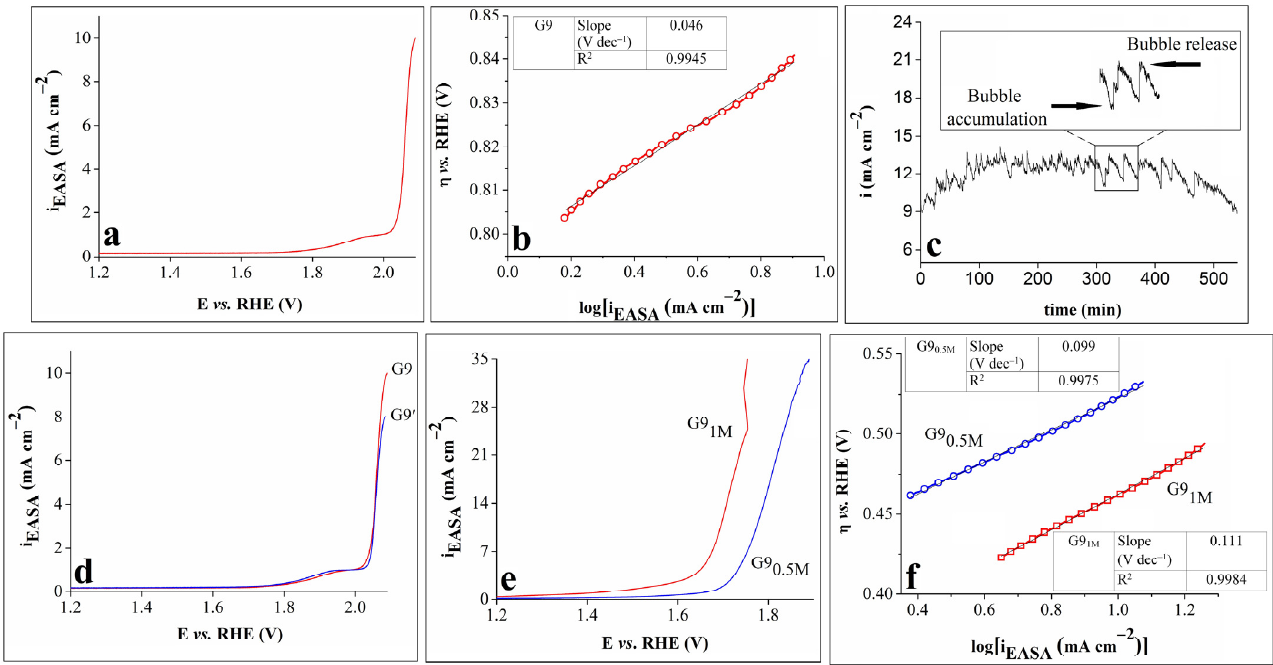
Figure 4. ( a ) LSV obtained on the G9 electrode in 0.1 mol L –1 KOH solution. ( b ) The Tafel curve for the G9 electrode in 0.1 mol L –1 KOH solution and inserted table showing the Tafel slope and R 2 values; ( c ) i-t curve recorded on the G9 electrode in 0.1 mol L –1 KOH solution, with inset